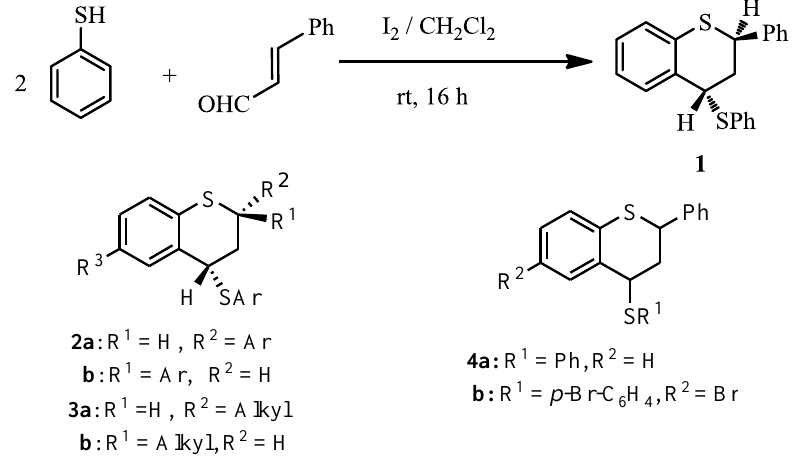
Scheme 1. Synthetic route to the title compound 1 .